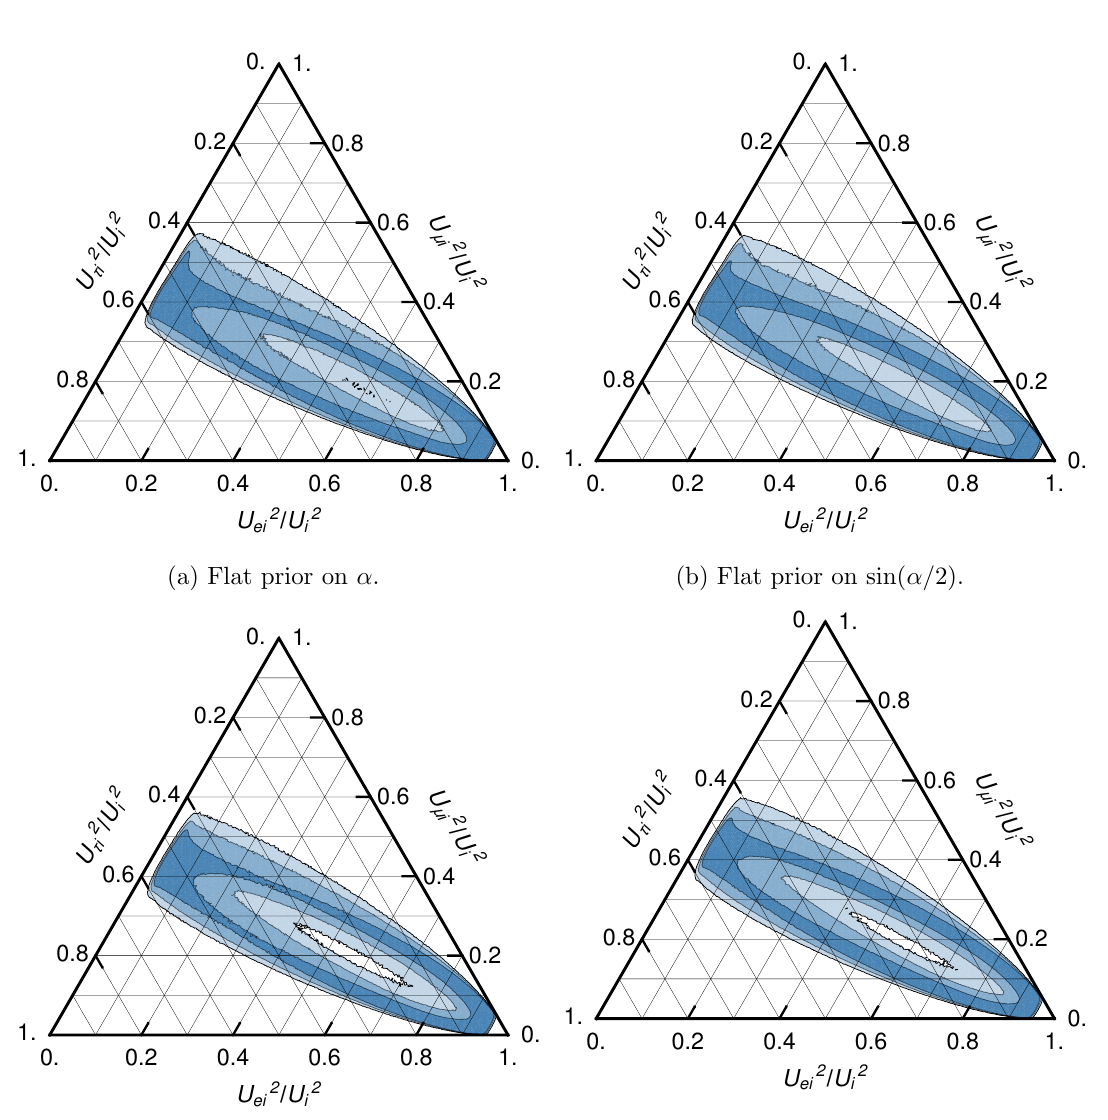
Figure 4. The di(cid:11)erent shades indicate the 1 (cid:27) (darkest), 2 (cid:27) and 3 (cid:27) (lightest) probability contours for the ratios U 2 =U 2 for n = 2 and IO that can be obtained from present neutrino oscillation data. a The upper panels (a) and (b) are based on the results from the NuFIT 3.1 global (cid:12)t to